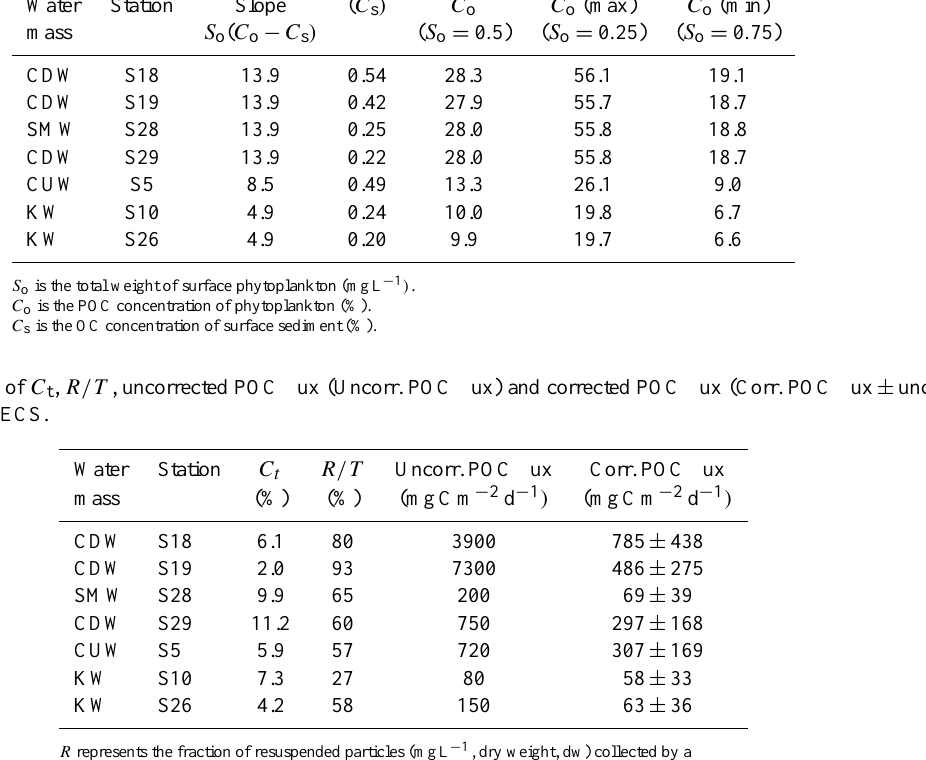
Table 3. Statistical data of linear regressions of POC values versus the reciprocal of total suspended matter concentrations in the East China Sea. The unit of C s and C o is %. C o (max) and C o (min) represent the minimum and maximum derived POC concentrations of phytoplankton. Water Station Slope ( C s ) C o C o (max) C o (min) mass S o ( C o − C s ) ( S o = 0 . 5) ( S o = 0 . 25) ( S o = 0 . 75)